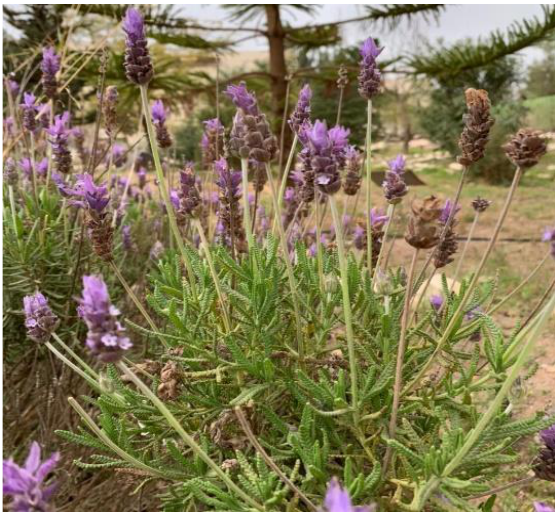
Figure 4. L. officinalis , (Lamiaceae) from Jerada,